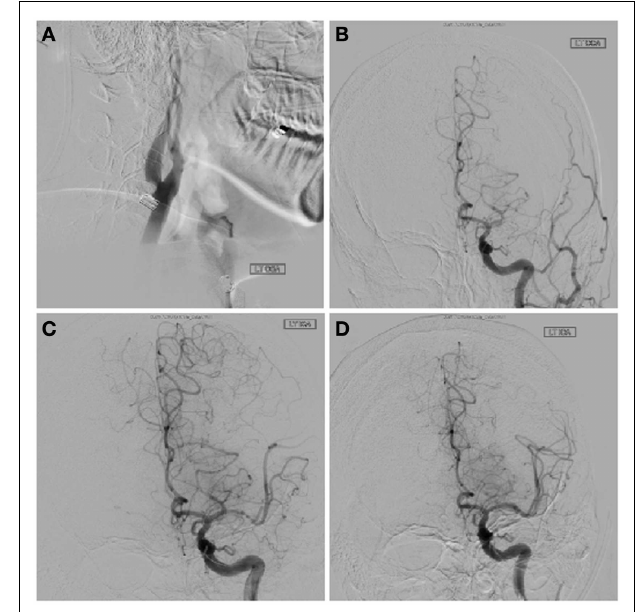
FIGURE 2 | Pre-treatment lateral angiogram of the cervical left ICA shows a focal thrombus attached to the posterior wall of the artery (A) . Intracranial angiography confirms a left M1 occlusion on left common carotid artery injection (B) . Solitaire stent deployment partially improved distal flow (C) . FinalTICI 2a angiographic result after embolectomy (D) .